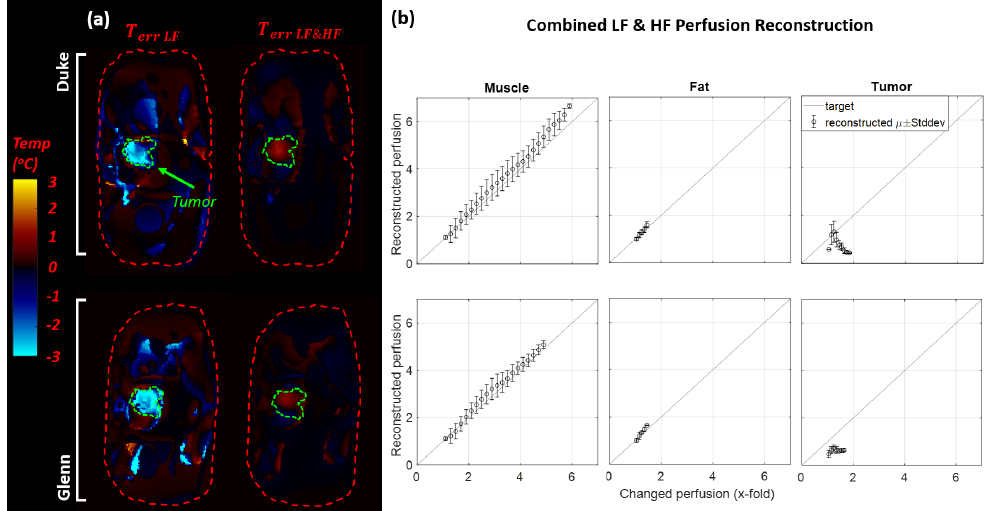
Figure 14. Reconstruction results from multifrequency EIT on Duke and Glenn: ( a ) cross-sectional view of the temperature error distribution; ( b ) reconstructed perfusion versus underlying perfusion plotted separately for muscle, fat, and tumor